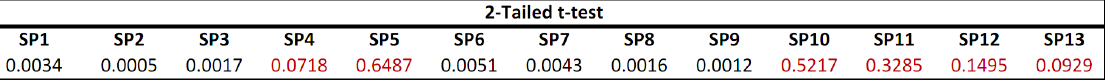
Table 4: The p-values were calculated using a two-tailed